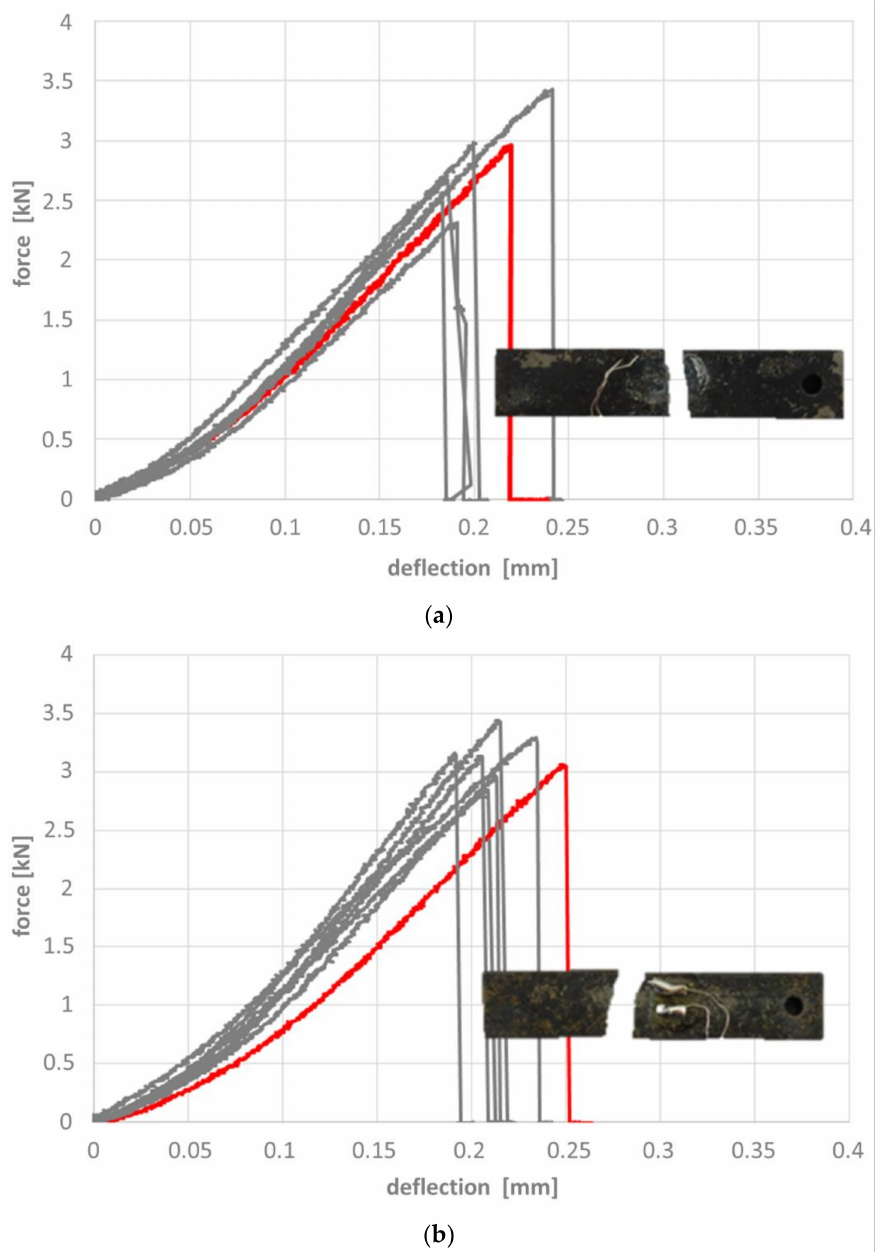
Figure 13. Force-deflection curves for samples with hollow glass microspheres, ( a ) carburized, and ( b ) carbonitrided. Inserts show the samples corresponding to the red